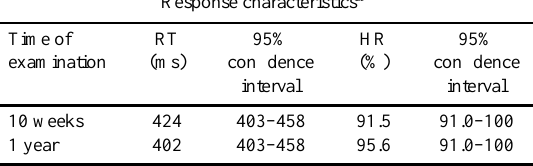
Table 4 Response characteristics